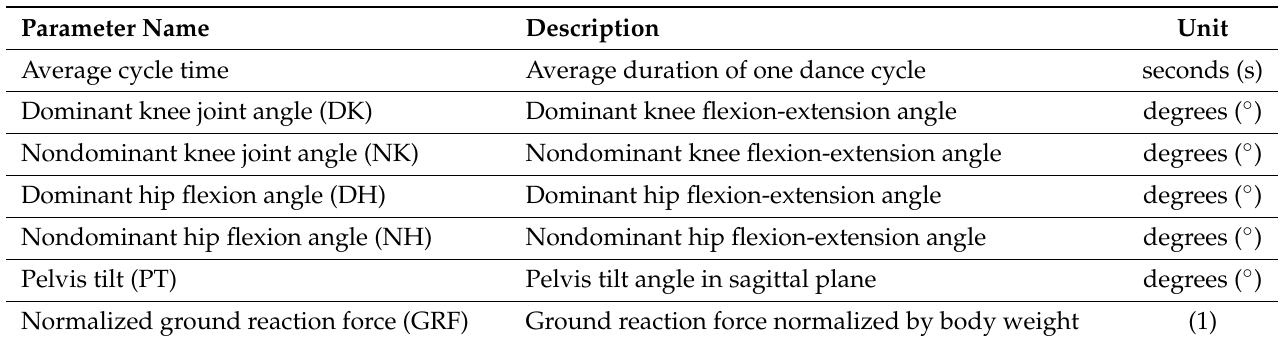
The recorded static stability test was also processed after the measurements. The mea- sured force magnitude ( x - y - z component, where x is anteroposterior, z is mediolateral, and y is the vertical axis) and the resultant force’s point of application (coordinates in the x - z plane) were used during the postprocessing procedure. The measurements were car- ried out with two force platforms; therefore, separate force and displacement coordinates were recorded for the right- (Force Plate No. 2) and the left- (Force Plate No. 1)